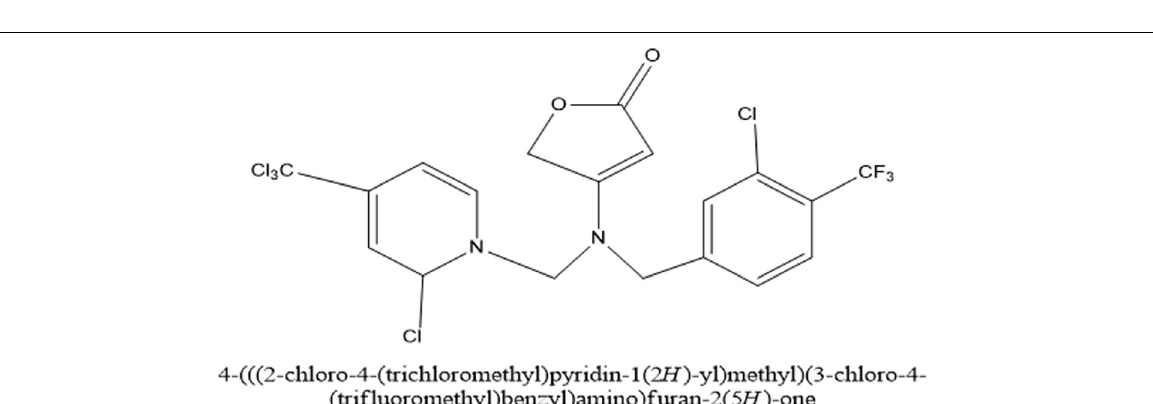
Fig. 11 2D structure of the designed compound (B)